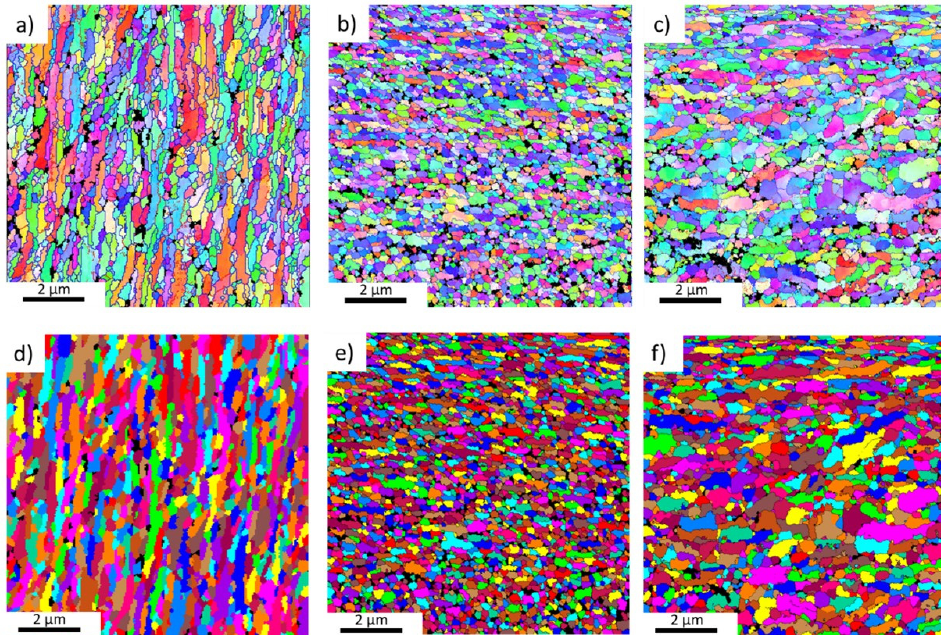
Figure 5. Orientation image maps taken on the ND ( a , d ), PD ( b , e ) and RD ( c , f ) planes of the sample processed with rotating mandrel. Panels ( a – c ) were colorized according to IPF (for color scheme, see the orientation triangle in Figure 4), and panels ( d – f ) were colorized by unique color.